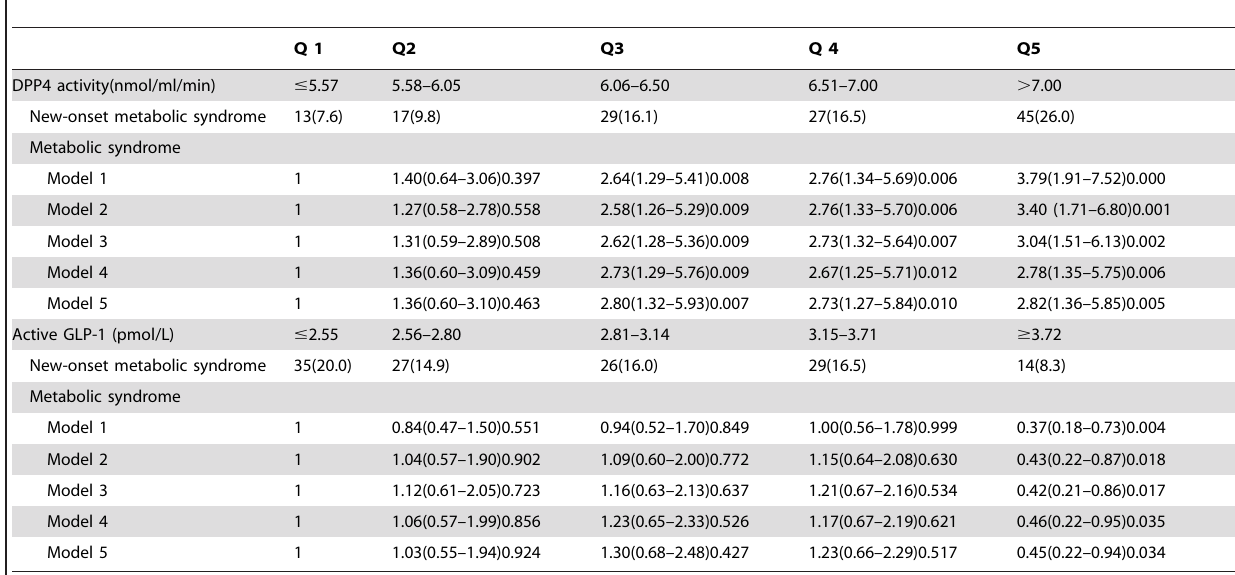
Table 4. ORs for new-onset metabolic syndrome in men according to baseline DPP4 activity and active